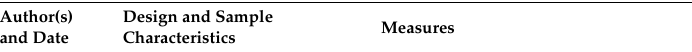
Table 1. Characteristics of included